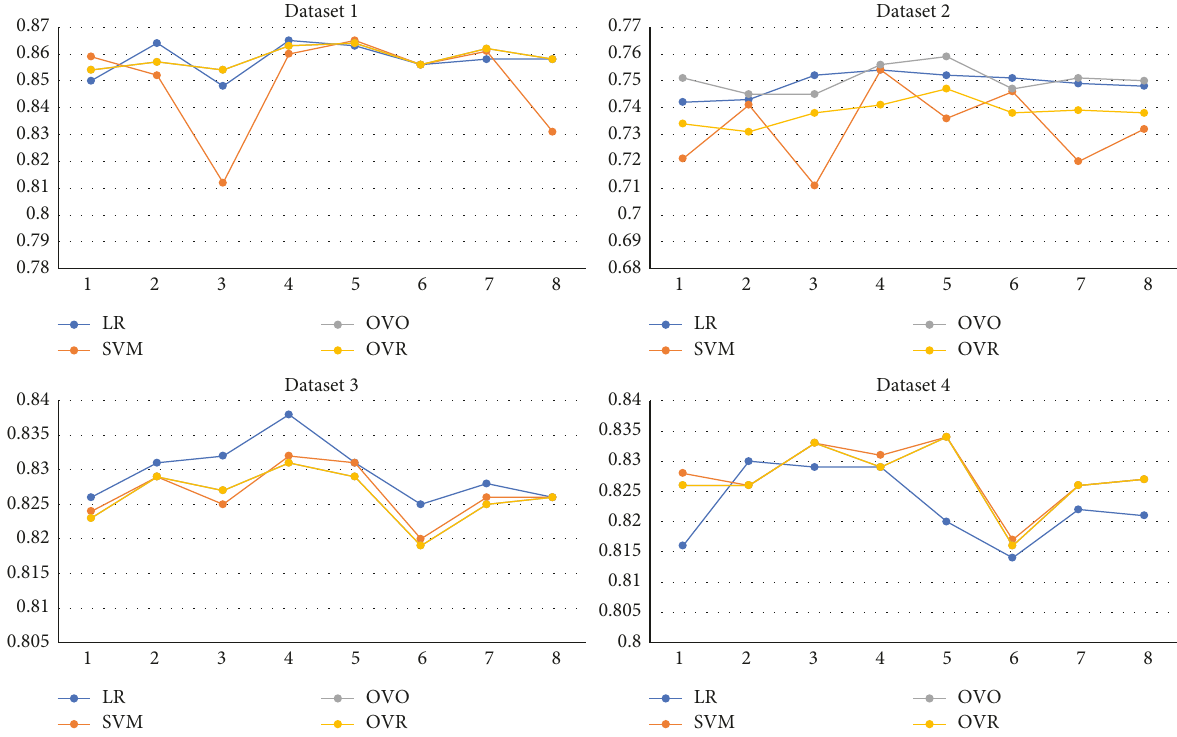
Figure 4: The accuracy results of various data augmentation techniques for Vietnamese sentiment analysis based on machine learning classifiers.